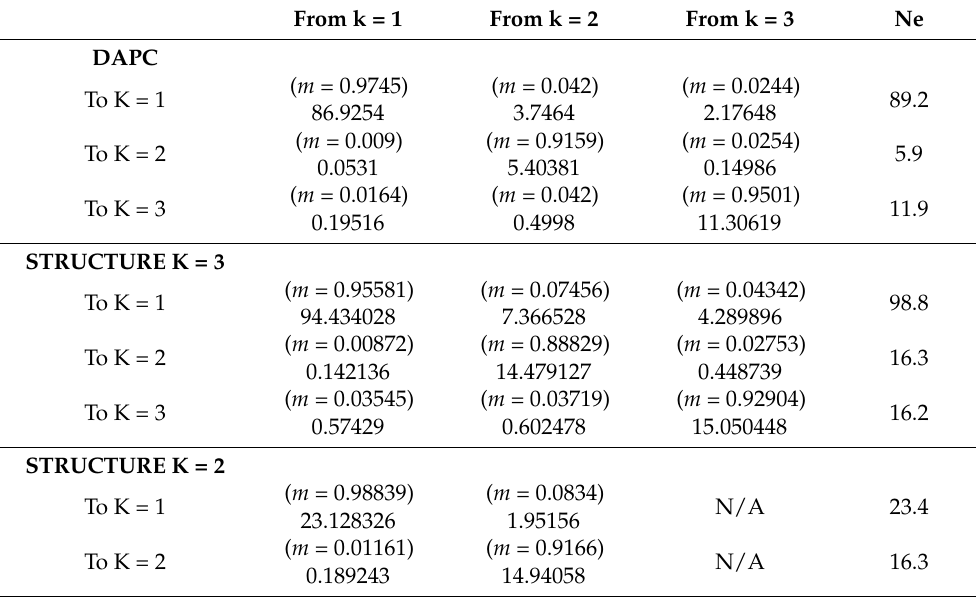
Table 5. The estimated numbers of migrating individuals, calculated as the product of the average migration rate ( m ) and effective population size ( Ne ). From k = 1 From k = 2 From k = 3